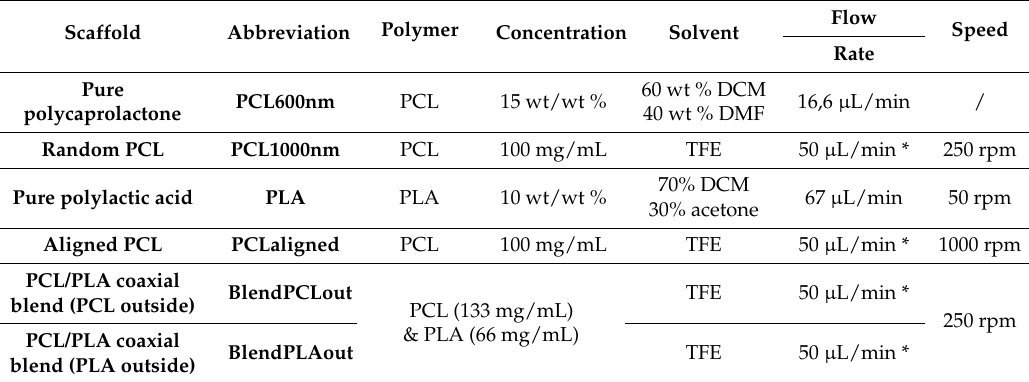
Figure 1. Design of the present study. The osteogenic and tenogenic potential of PCL- (polycaprolactone) and PLA-based (polylactic acid) electrospun scaffolds was investigated in the absence of specific differentiation media with a cross-analysis of biological, morphological and mechanical behaviors. Table 1. Production parameters of the electrospun scaffolds